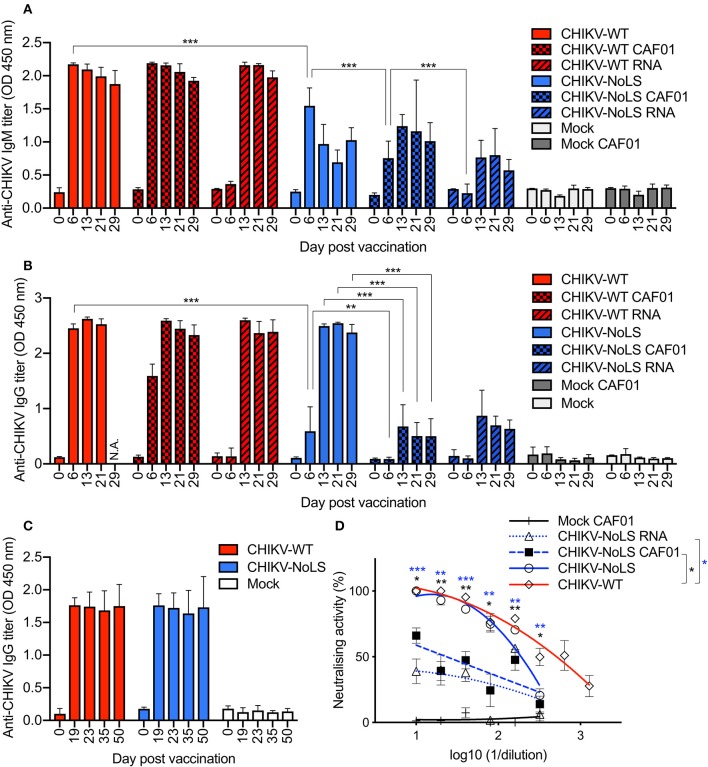
Antibody response in CHIKV-NoLS CAF01 inoculated C57BL/6 mice. C57BL/6 mice were inoculated with viable virus particles (104 pfu CHIKV-WT or CHIKV-NoLS), CAF01 delivered RNA (2 μg CHIKV-WT or CHIKV-NoLS RNA complexed with 0.3 mg CAF01), or RNA alone (2 μg CHIKV-WT or CHIKV-NoLS RNA) subcutaneously in the ventral/lateral side of the right foot. Mock inoculated mice received 20 μl VP-SFM media or VP-SFM media containing 0.3 mg CAF01. Serum was harvested at various times post inoculation and titrated for IgM (A) and IgG (B,C) by ELISA. (D) Neutralizing antibody titers at day 30 post inoculation were examined. Each symbol represents the mean ± standard error from 5 to 6 mice. Statistical significance of IgM and IgG titers was analyzed by one-way ANOVA with Tukey posttests and neutralizing antibody titers by Kruskal–Wallis test with Dunn's posttests (groups indicated on the figure legend by the bar and *color). *P < 0.05, **P < 0.005, and ***P < 0.001. N.A., data not available.